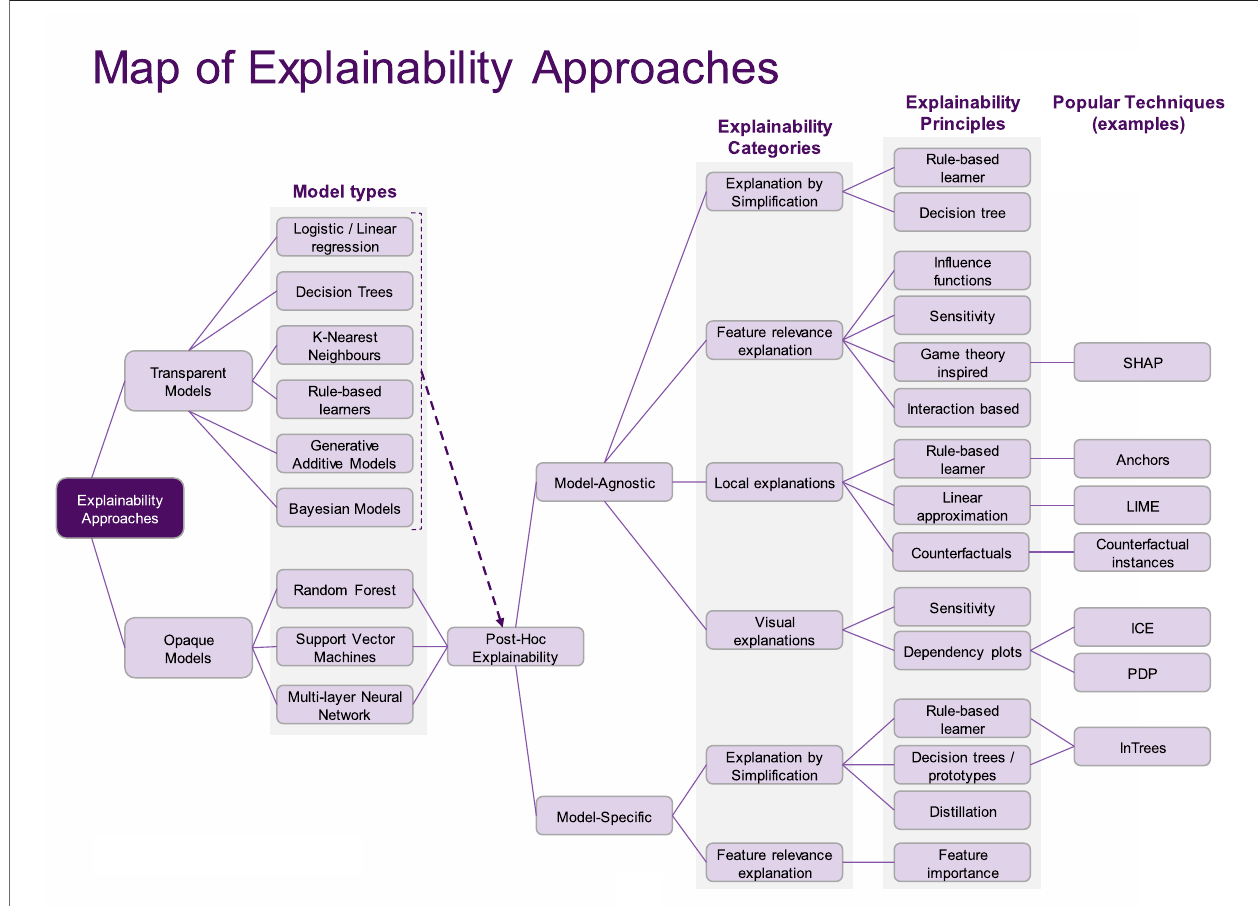
FIGURE 2 | A taxonomic view on